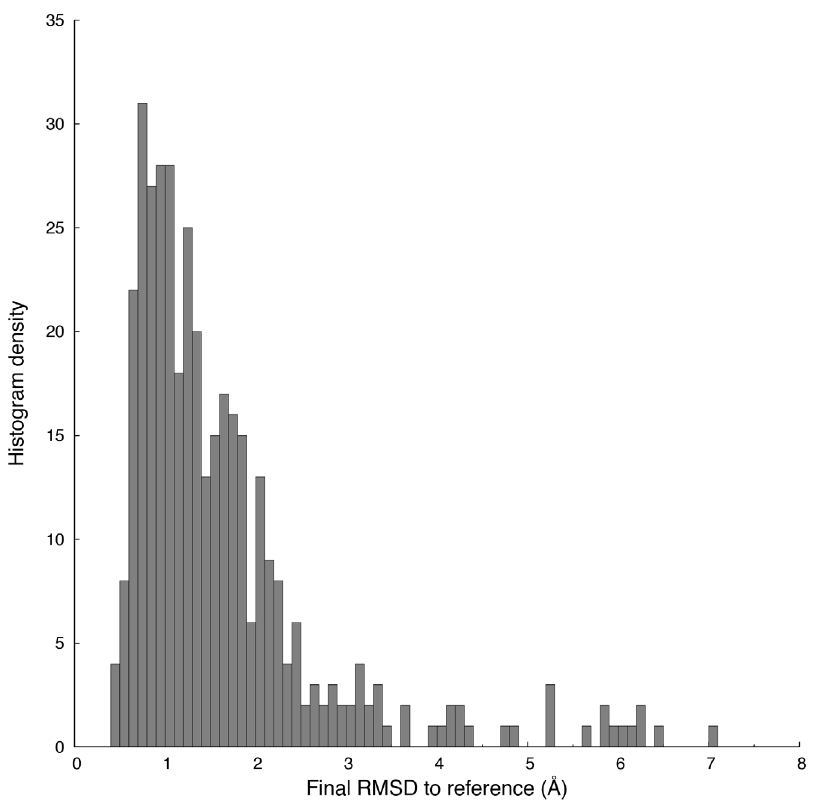
Figure 3. Heavy-atom RMSD values obtained at the highest resolution . The histogram shows the heavy atom RMSD values of 381 protein structures. obtained at the highest digital resolution corresponding to 1250 sampling